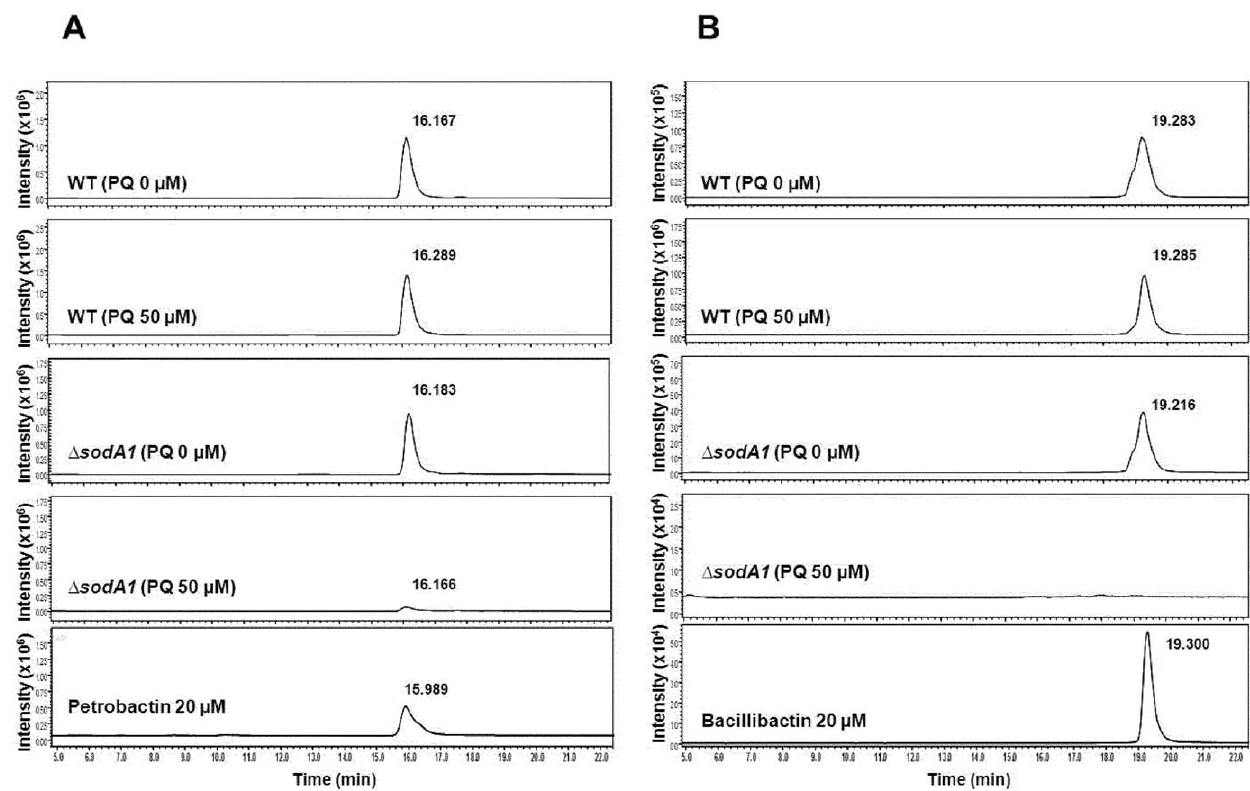
Figure 3. LCMS chromatogram of petrobactin and bacillibactin in the extracts obtained from the IDM cultures of B.anthracis with or without addition of paraquat. (A) SIM chromatogram of petrobactin at the mass range of m/z 719.3 [M + H] + . The peaks at 15.989–16.289 min represent petrobactin. (B) SIM chromatogram of bacillibactin at the mass range of m/z 883.2 [M + H] + . The peaks at 19.216–19.300 min represent bacillibactin.